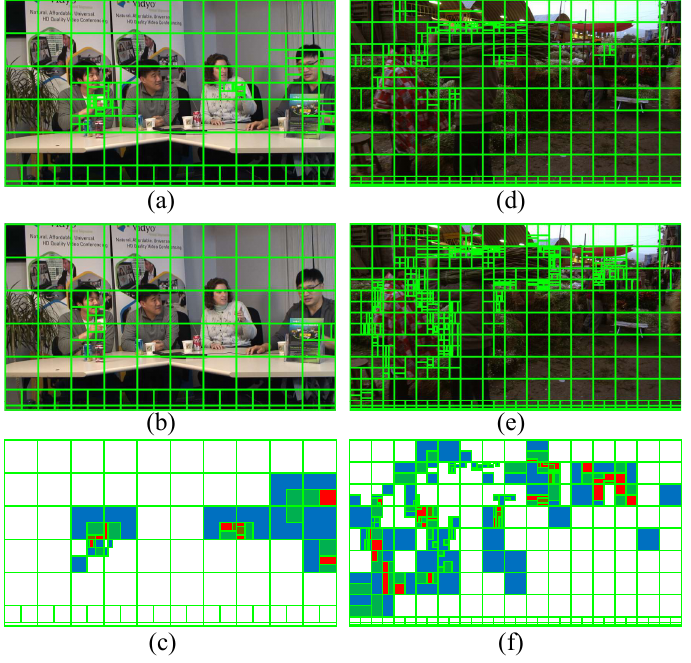
Figure 2. Optimal CU partition of two successive frames of sequences “FourPeople” and “Mar- ketPlace” and the absolute differences of CU depth among frames. ( a , b , d , e ) denote the original optimal CU partition. ( c , f ) represent the absolute difference between ( a , b ), and the absolute difference between ( d , e ),